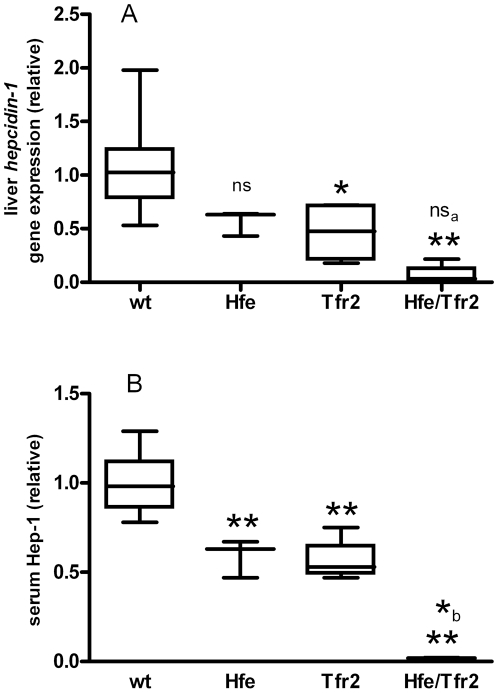
Serum Hep-1 levels and liver hepcidin-1 expression obtained for mouse models of hereditary hemochromatosis relative to wild-type (wt) mouse.Data are depicted as lower quartile, median and upper quartile (boxes), and minimum and maximum ranges (whiskers). Statistical analysis were performed using ANOVA and Dunnett's comparisons. Ns, not significantly different; *, P<0.05; **, P<0.01; all compared to wild-type; a and b, significancy of difference to homozygous Tfr2 mutated mice.